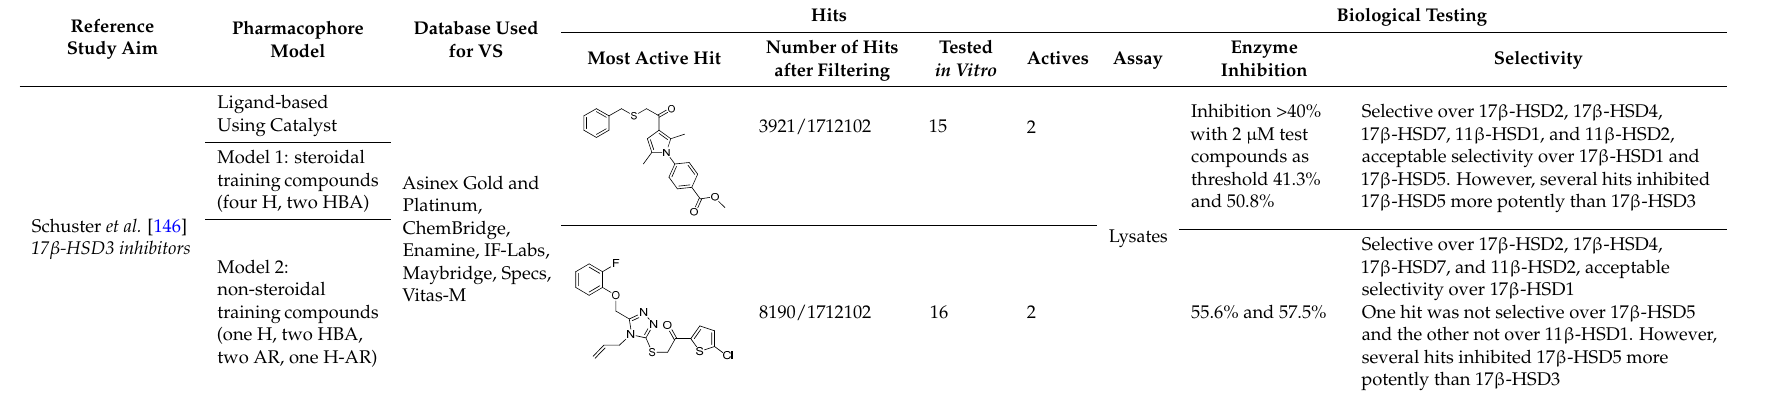
Table 3. Summary of the 17 β -HSD3 pharmacophore-based virtual screening study.